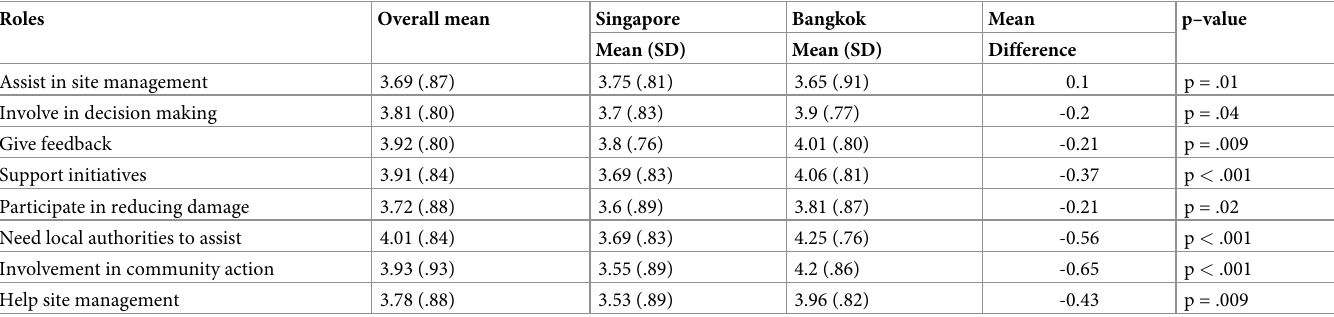
Table 5. Independent sample t-test results: Desired involvement and roles